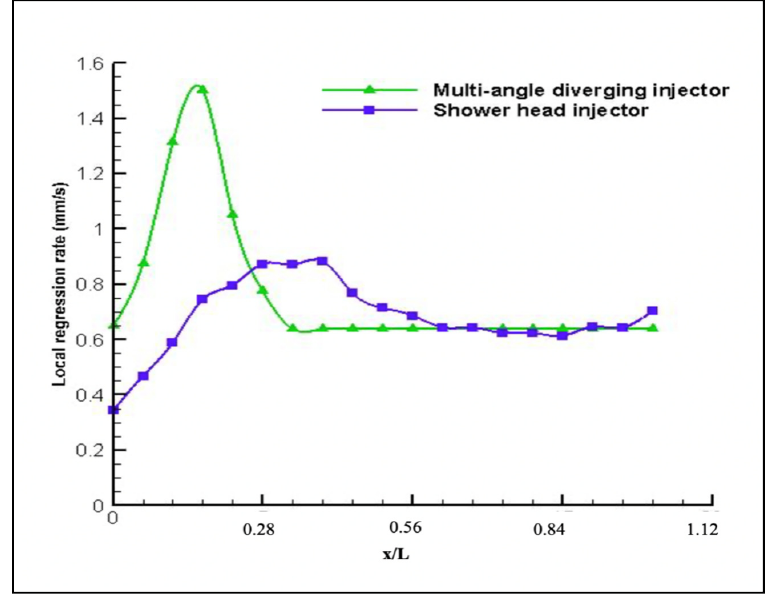
Figure 7. Local regression rate vs. x/L using the two injector designs using PVC fuel.